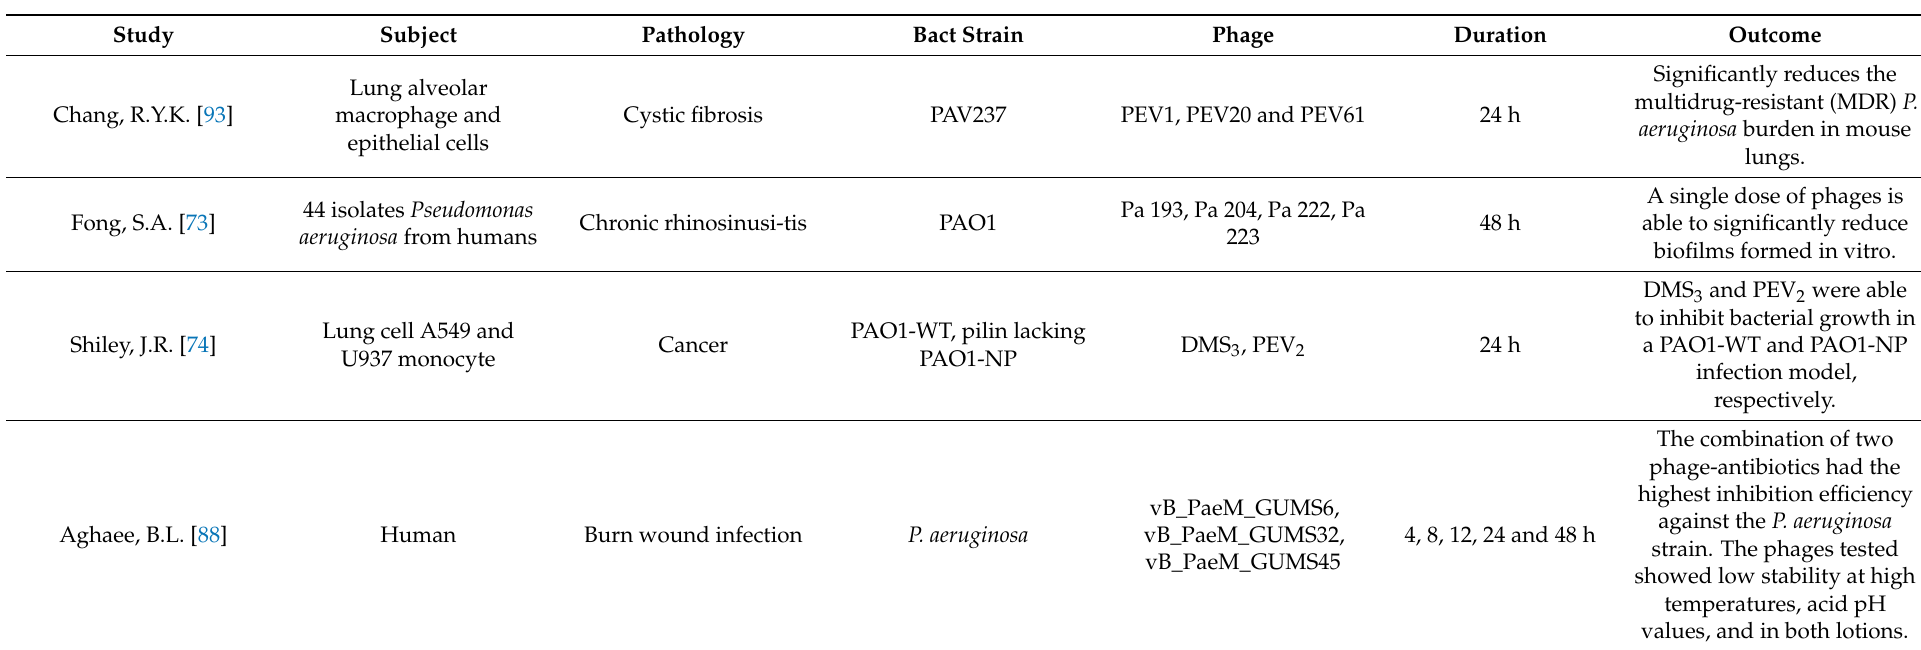
Table 3. In vitro studies about phage therapy for Pseudomonas aeruginosa